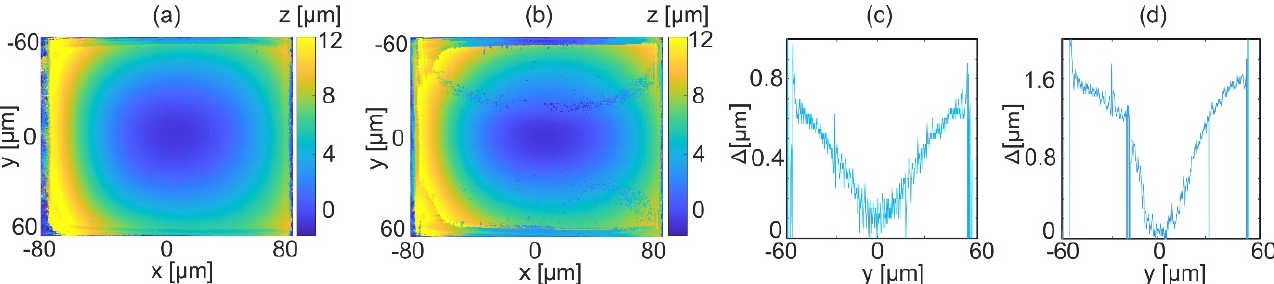
Figure 11. Influence of focusing distance on reconstructed shape: ( a ) topography reconstruction at z = − 1.96 μ m, ( b ) topography reconstruction at z = − 3.96 μ m, ( c ) difference in vertical cross-sections of the reconstructed object at z = − 0.96 μ m and − 1.96 μ m, and ( d ) difference in vertical cross-sections of the reconstructed object at − 0.96 and − 3.96 μ m.